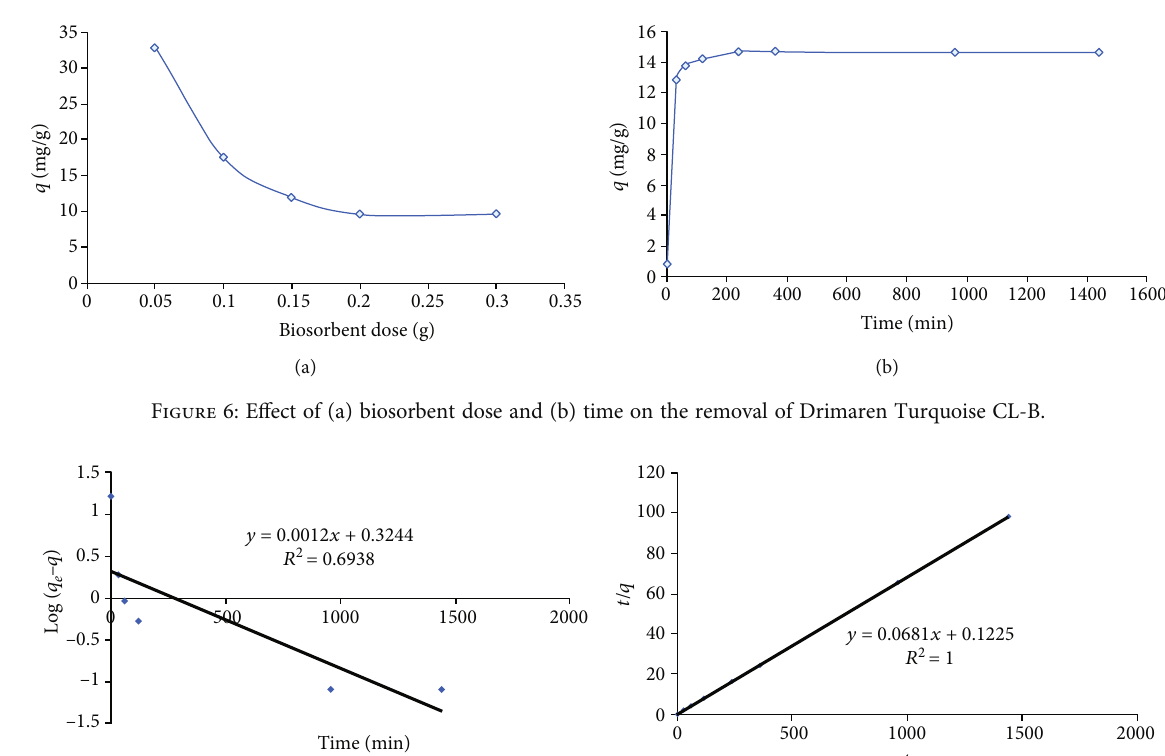
Figure 7: Reaction kinetics plots. (a) Pseudo-1 st -order and (b) pseudo-2 nd -order for the removal of Drimaren Turquoise